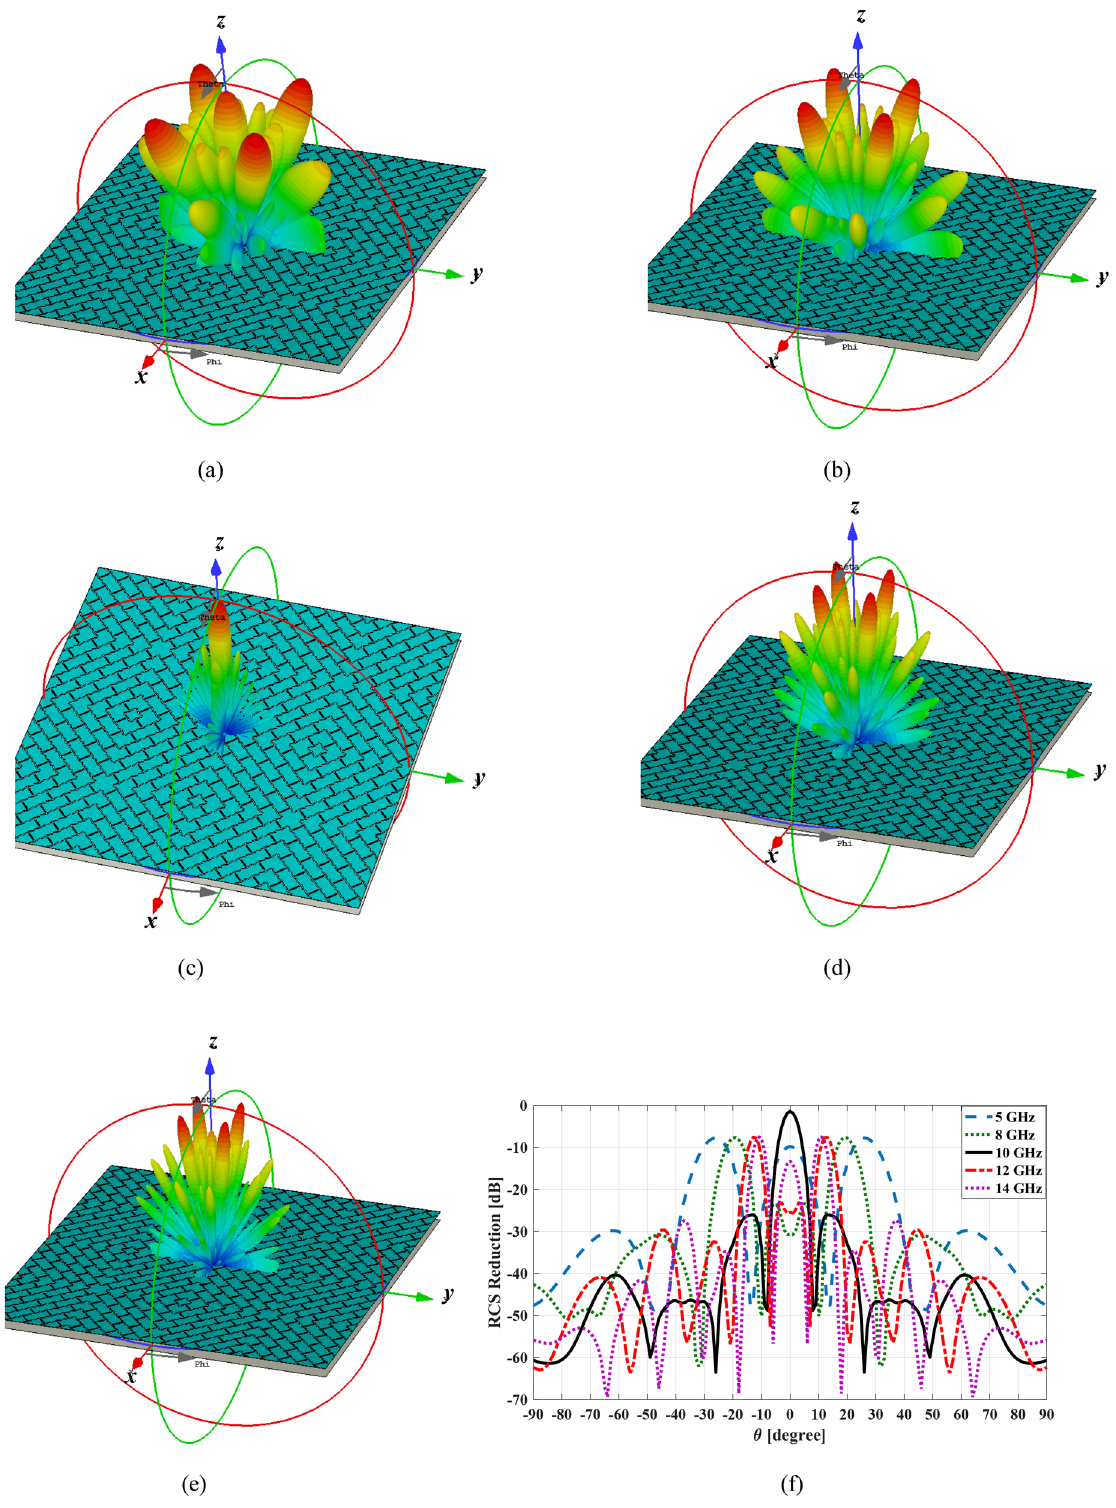
Figure 15. The 3D scattering pattern in ( a ) f = 5 GHz, ( b ) f = 8 GHz, ( c ) f = 10 GHz, ( d ) f = 12 GHz and ( e ) f = 14 GHz, ( f ) the 2D scattering pattern in ϕ